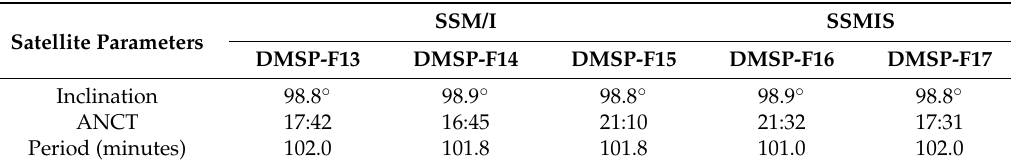
Figure 1. Study area overlapped with F13 SSM/I brightness temperatures and F17 SSMIS brightness temperatures (for the channel of 19H, 19V, 22V, 37V) on 20 March 2007. Table 1. Satellite parameters of DMSP with SSM/I and SSMIS.